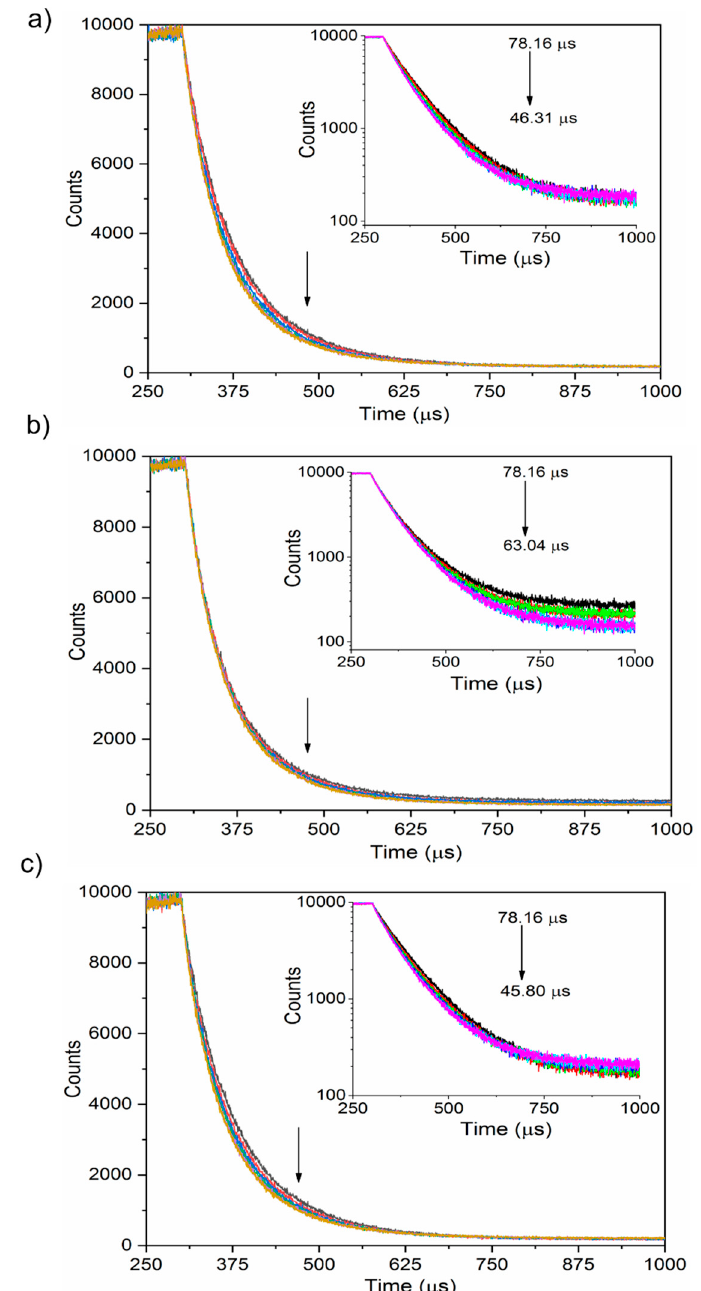
Figure 6. PL decay profiles of SiQDs/F127 nanoparticles with the incremental addition of blood plasma proteins (down arrow), human serum albumin ( a ), fibrinogen ( b ), and transferrin ( c ). Insets show the fluorescence lifetime of nanoparticles after interaction with proteins.